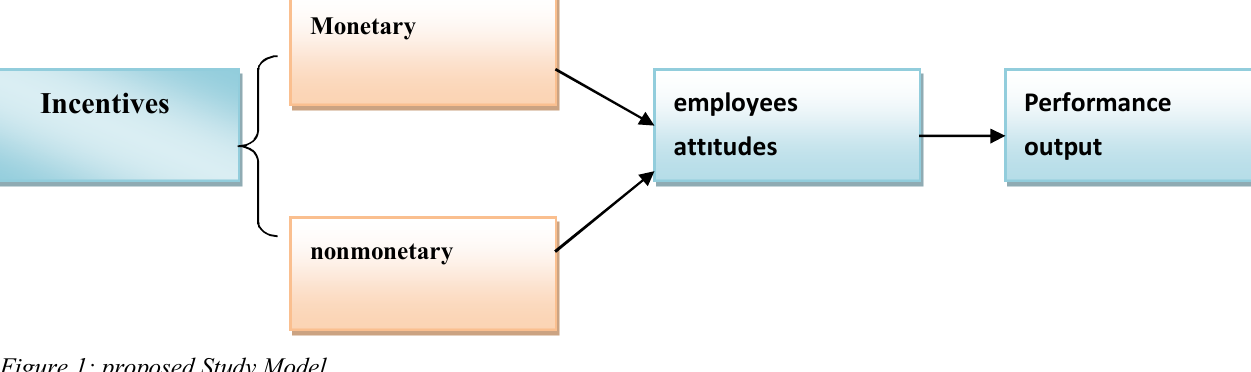
Figure 1: proposed Study